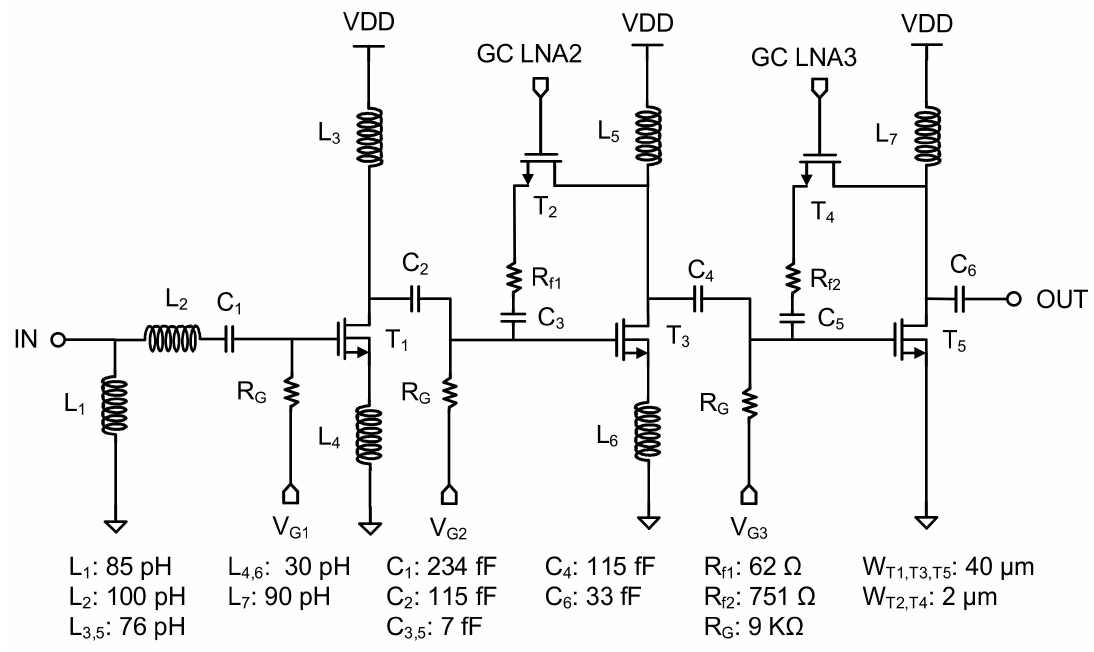
Figure 2. Schematic of 60 GHz low noise